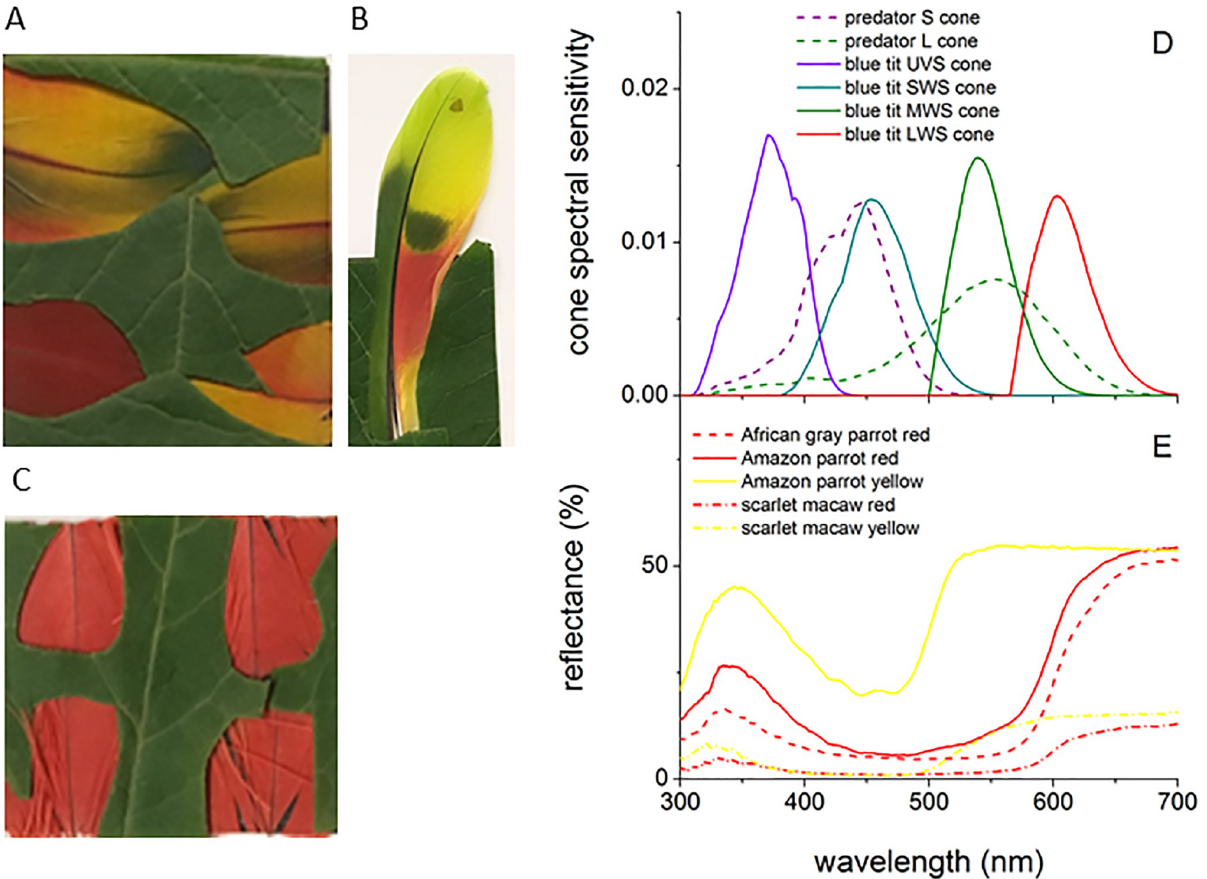
Fig 3. Parrot feather images, cone sensitivity spectra and feather reflectance spectra. (A) Scarlet macaw, (B) Amazon parrot and (C) African grey parrot feather samples. (D) Comparison of the cone photoreceptor spectral sensitivities for the blue tit, which has tetrachromatic ultraviolet sensitive (UVS) color vision similar to that of parrots, and the ferret, which has dichromatic color vision similar to that of cats and dogs. All spectra are multiplied by the D65 illuminance spectrum used to model sunlight and normalized to unit area. (E) Reflectance spectra of the parrot feather red and yellow patches studied